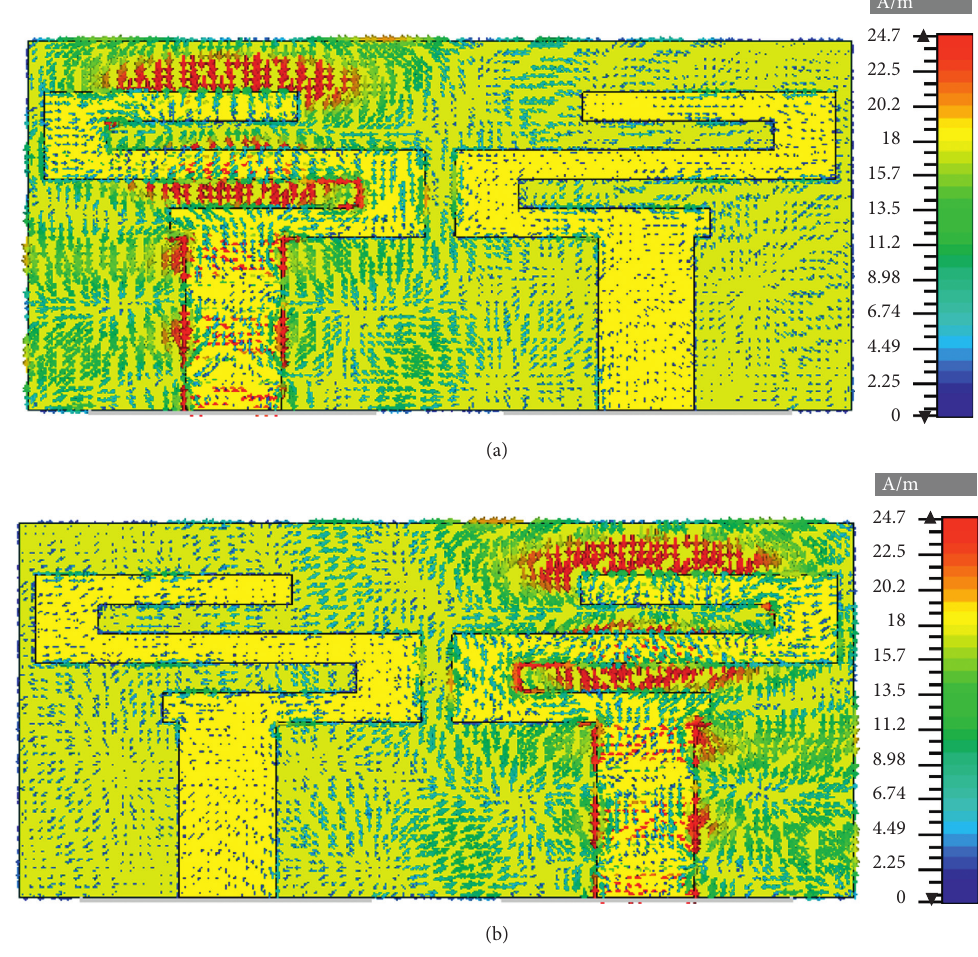
Figure 8: Surface currents distributions of (a) port 1 and (b) port 2 at 28GHz.